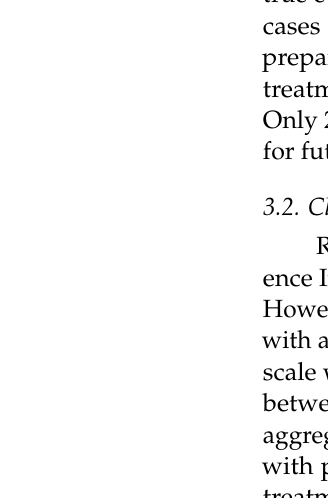
Table 1: Average discomfort and discomfort range is reported here on a 10-point scale for those subjects reporting discomfort during procedures. Seven subjects did not report this data. Note that values of 0 indicate no discomfort, while values of 10 indicate pain.